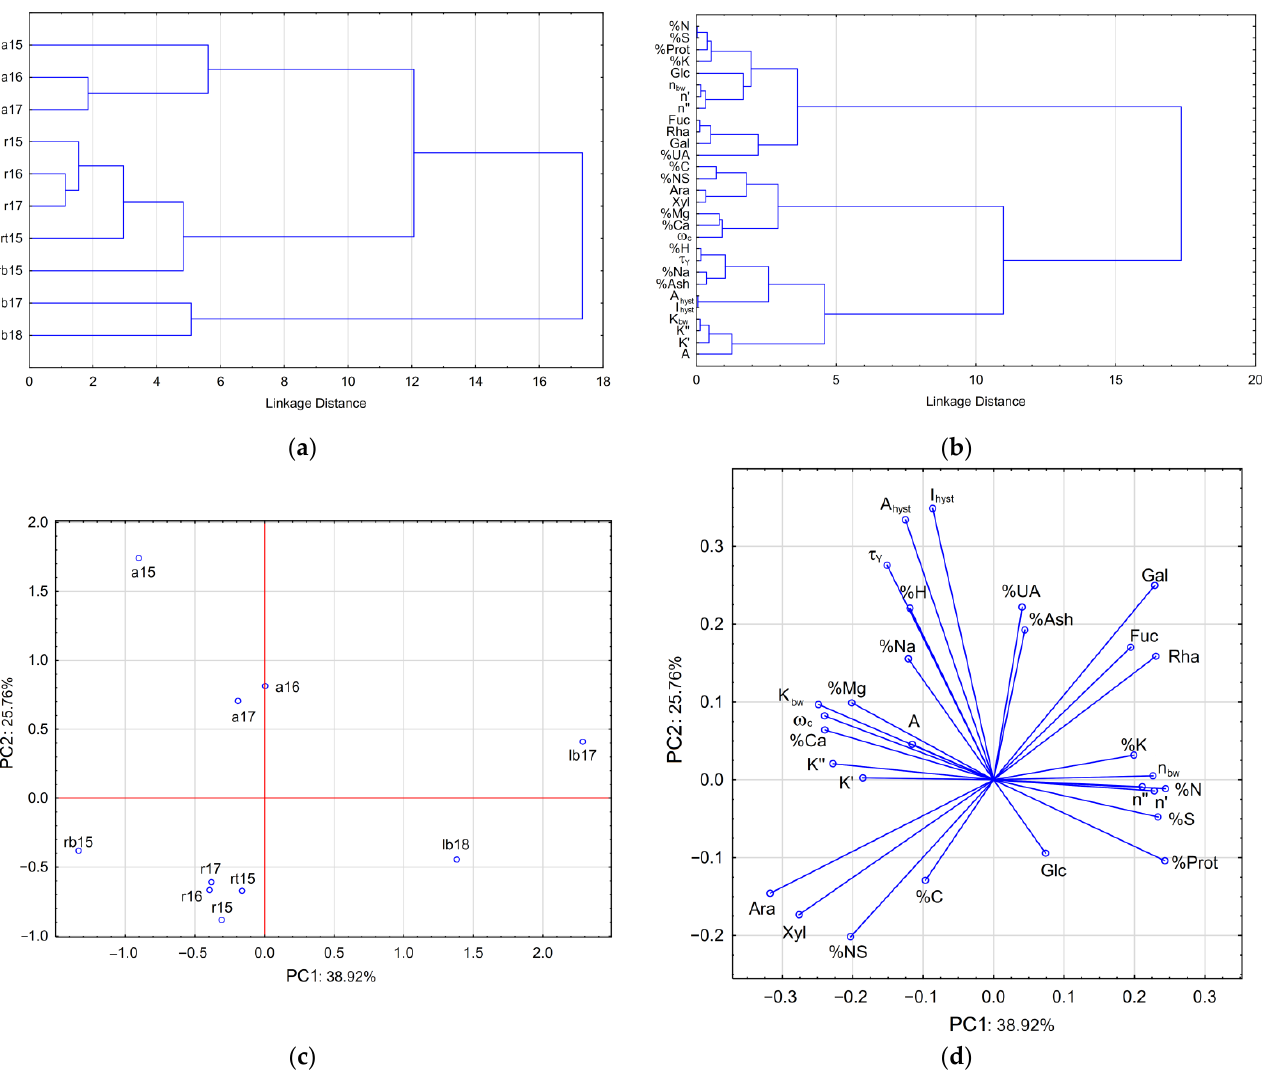
Figure 5. PCA projections of the cases ( a ) and variables ( b ) on the factor plane PC1 versus PC2. Dendrograms of similarity for flaxseed cultivars ( c ) and analytical values ( d ).